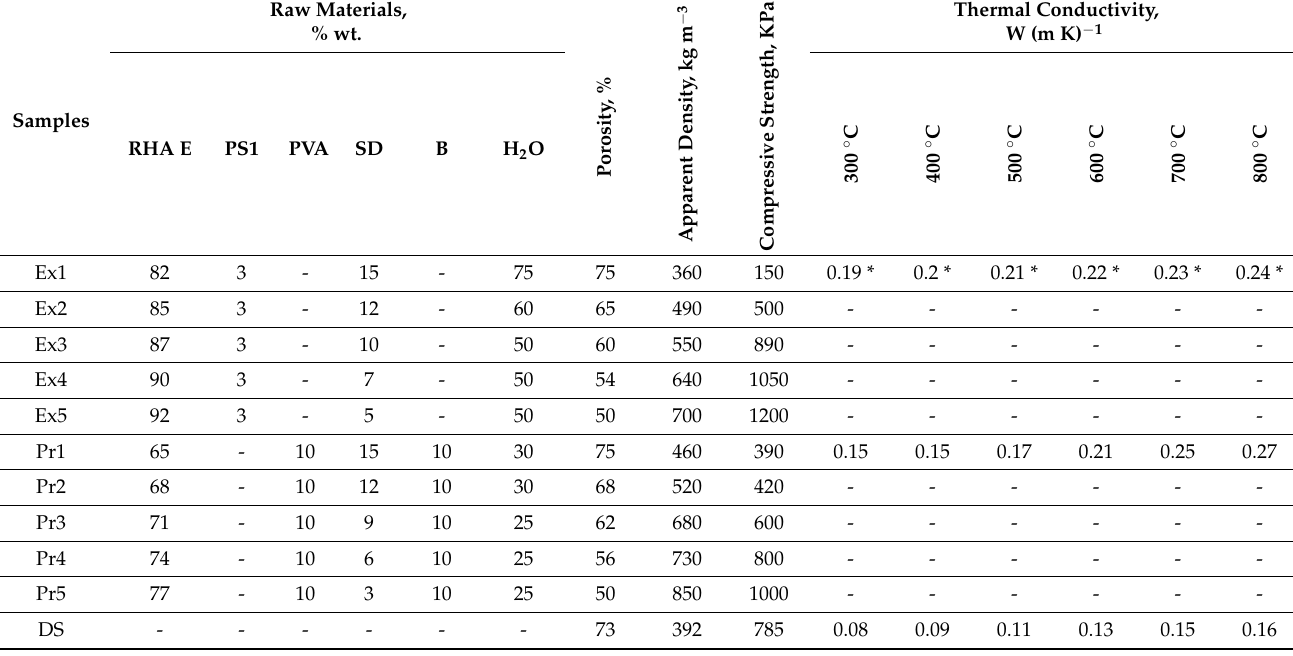
Table 5. Composition and properties of RHA Ex and RHA Pr thermal insulators. Data from [15].